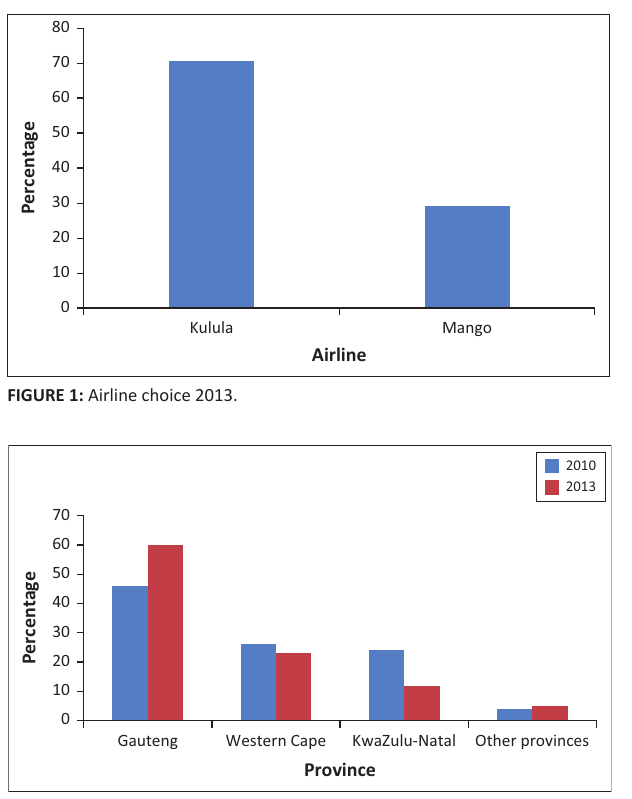
FIGURE 2: Province of residence. FIGURE 4: Gauteng respondents’ residential distribution (2013).